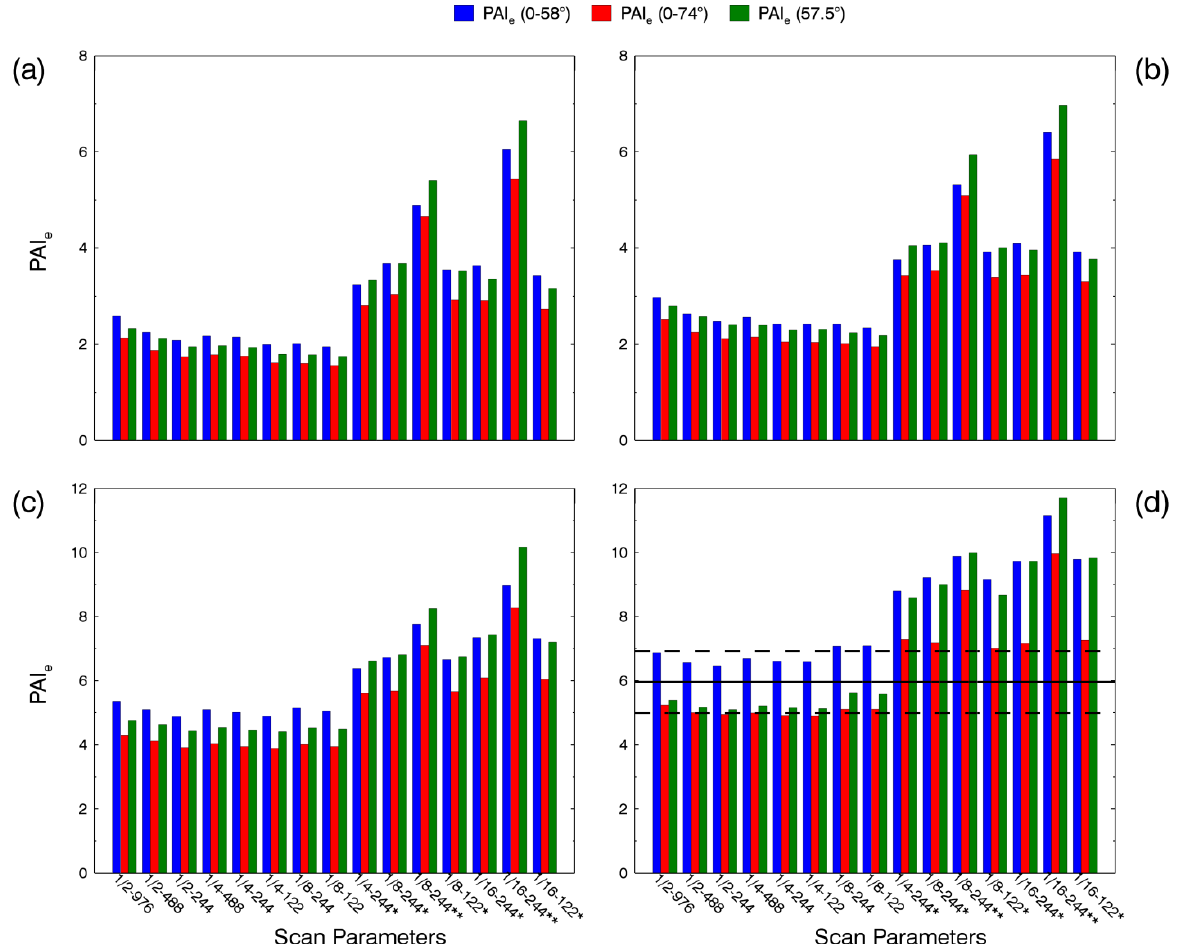
Figure 9. Effective PAI based on the scans collected at the Oak-Beech plot with different scan parameters. Leaf-off dates: ( a ) 24 April 2013. ( b ) 2 May 2013. Leaf-on dates: ( c ) 10 May 2013. ( d ) 7 June 2013. Scan parameters: Scan resolution is displayed as the fraction of the maximum scan resolution. Scan speed is displayed in kpts/s. The single and double asterisks denote scans performed with the 2-factor and 4-factor noise compression. The lines in 9 (d) depict the mean (solid line) and standard deviations (dashed lines) of the litterfall LAI for the period